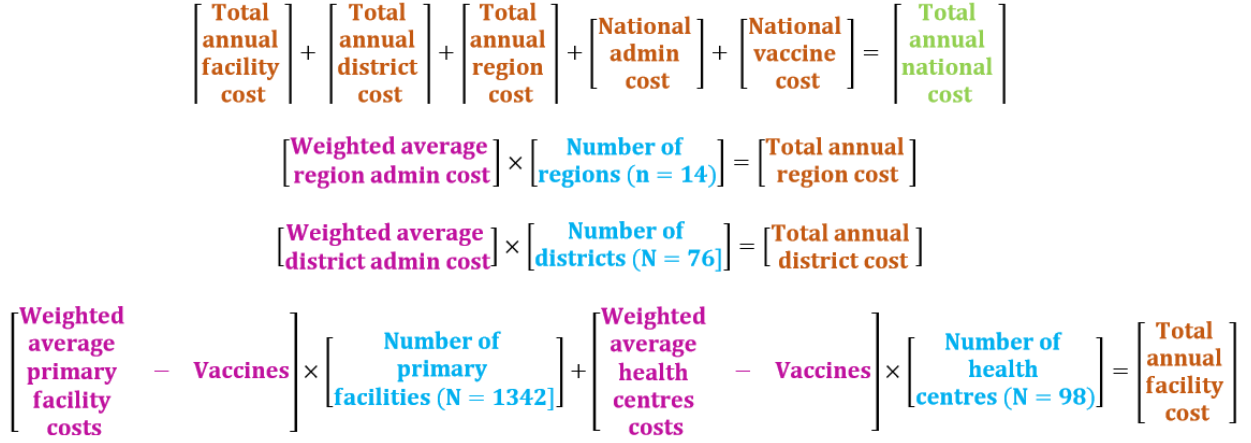
Figure 1. Aggregation method for calculating costs of HepB-BD implementation in Senegal. Source: Adapted from Brenzel L. Common approach for the costing and financing analyses of routine immunization and new vaccine introduction costs (NUVI). Bill and Melinda Gates Foundation; 2013.